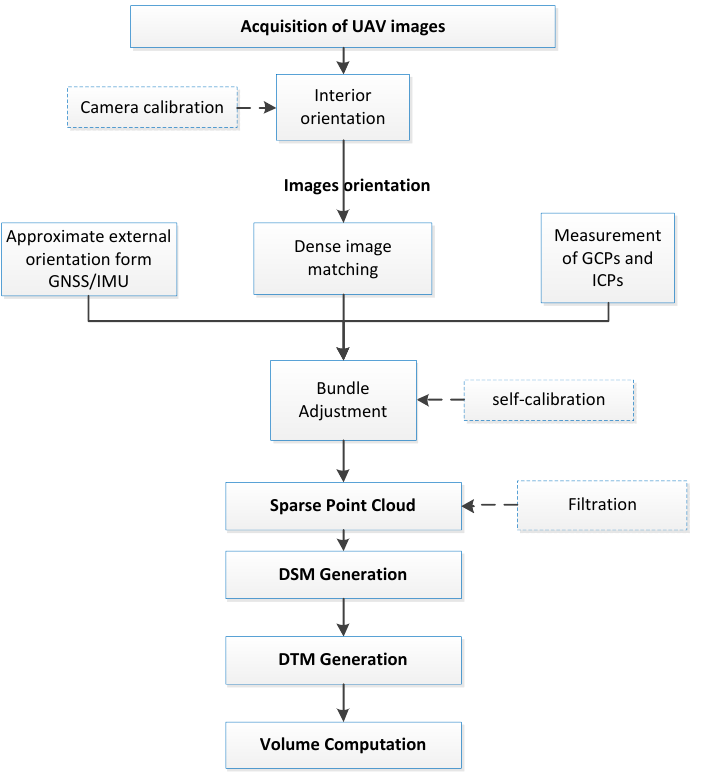
Figure 10. Overall methodology of data processing.